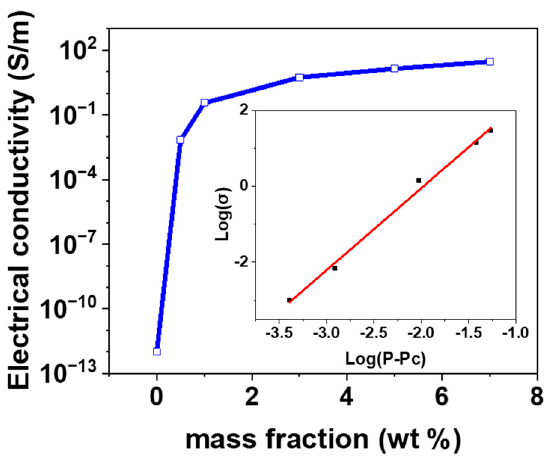
Figure 2. The electrical conductivity of CNT/PDMS composites as a function of mass fraction (wt%).